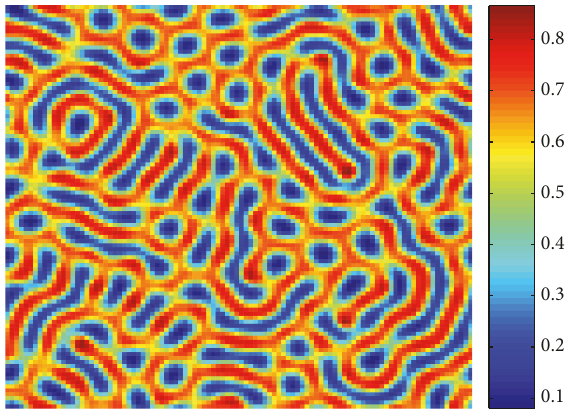
Figure 9: Transitional vegetation pattern between the labyrinth pattern and the gapped pattern. 𝐴 = 1.67 × 10 −3 . 𝑇